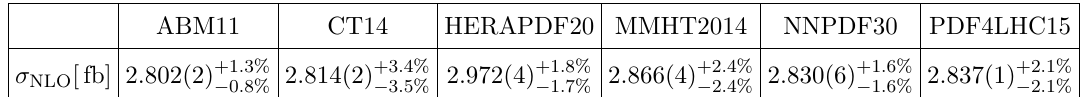
Figure 3 . Combined variation of the factorization and renormalization scale for di(cid:11)erent PDF sets. For the NLO results obtained with the PDF4LHC15 and HERAPDF20 sets, the corresponding PDF uncertainties are shown as bands.